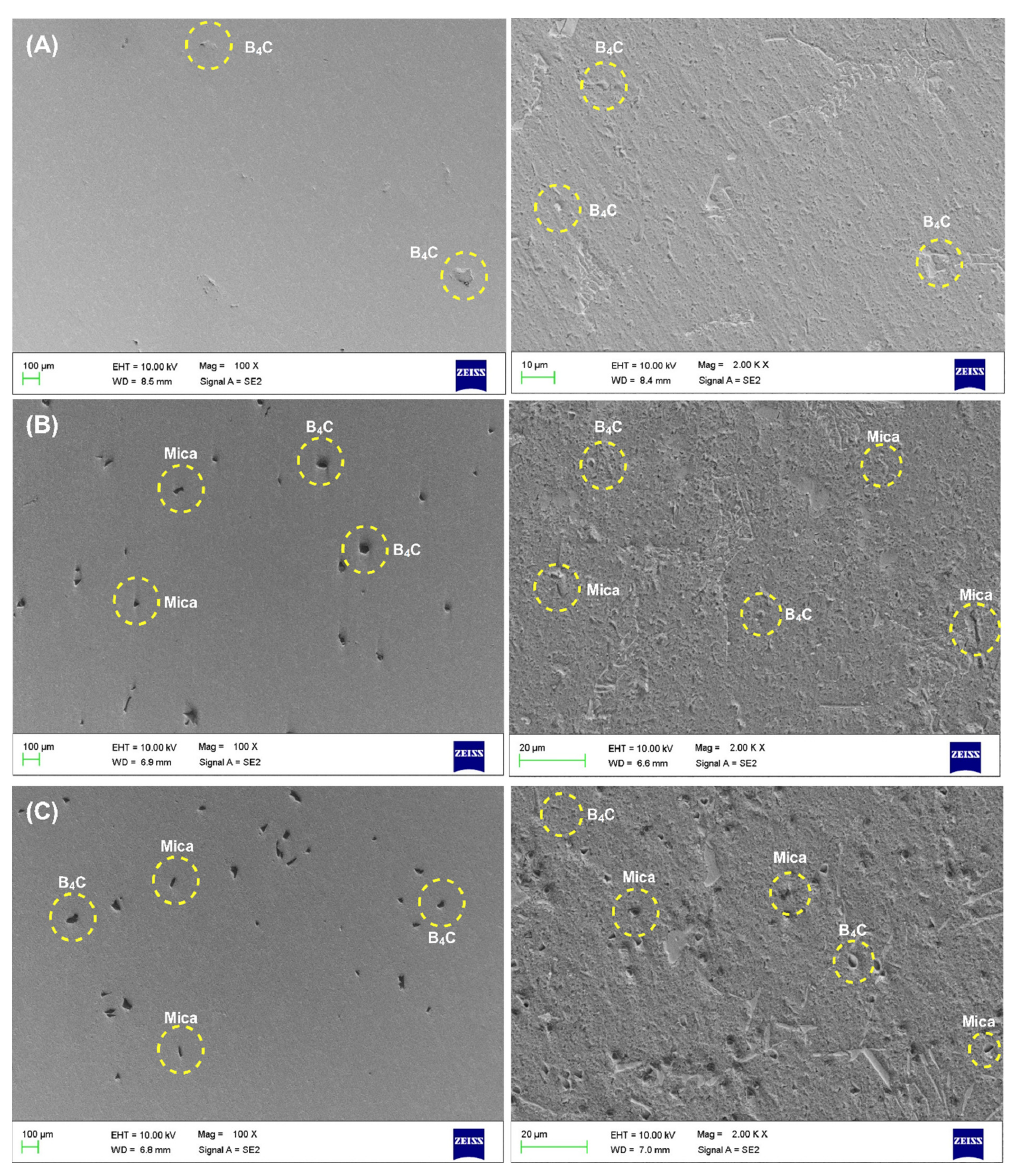
Figure 4. SEM images of fabricated composites (1000×). ( A ) 90 wt.% Al/10 wt.% B 4 C/0 wt.% mica ( B ) 87 wt.% Al/10 wt.% B 4 C/3 wt.% mica. ( C ) 84 wt.% Al/10% B 4 C + 6% mica.